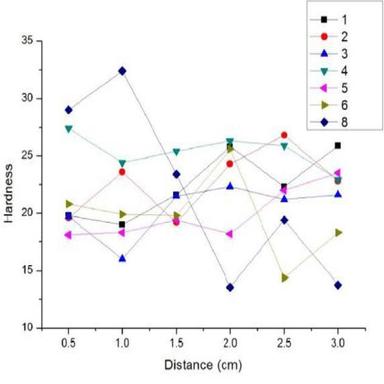
Hardness at various points on different samples .